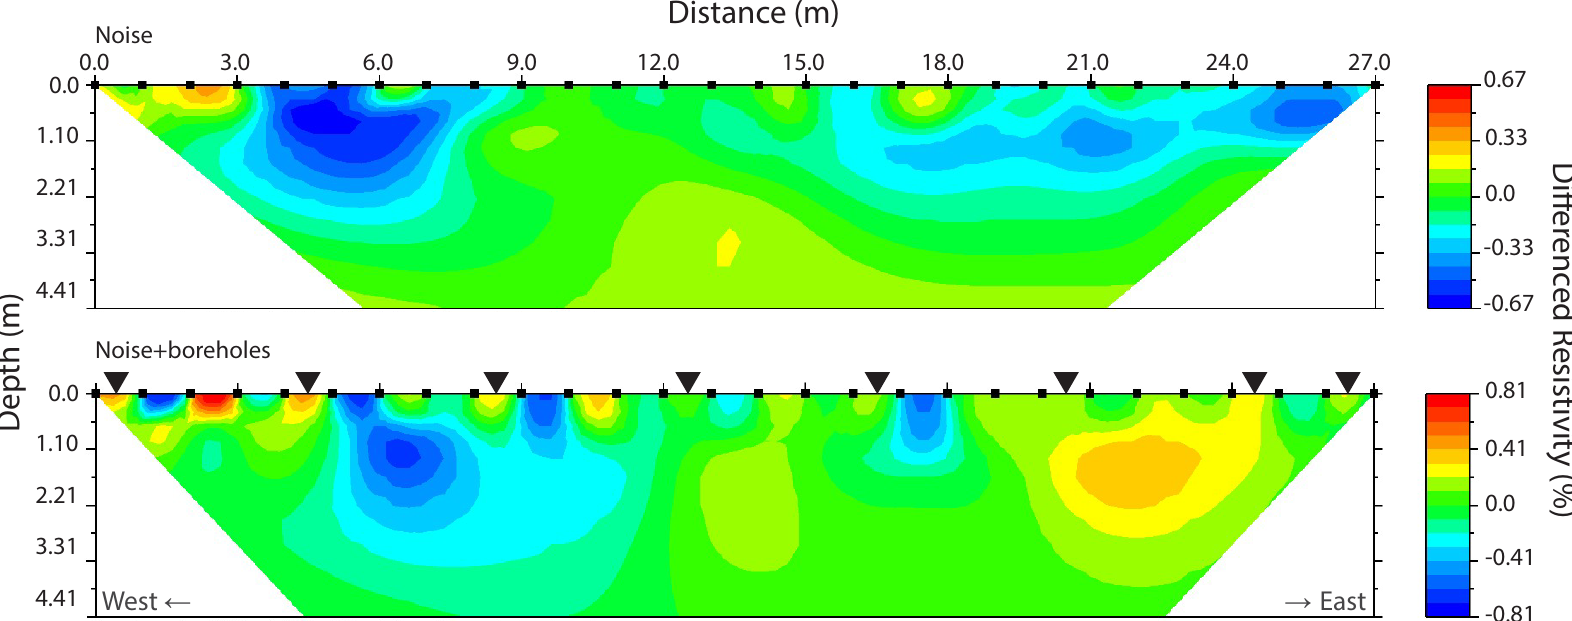
Figure 11. Comparison between regular noise ( top ) and noise after drilling boreholes for gravimetric sampling exactly located on the transect of two ERT measurements on 20 December ( below ). The black triangles in the lower transect indicate the location of the